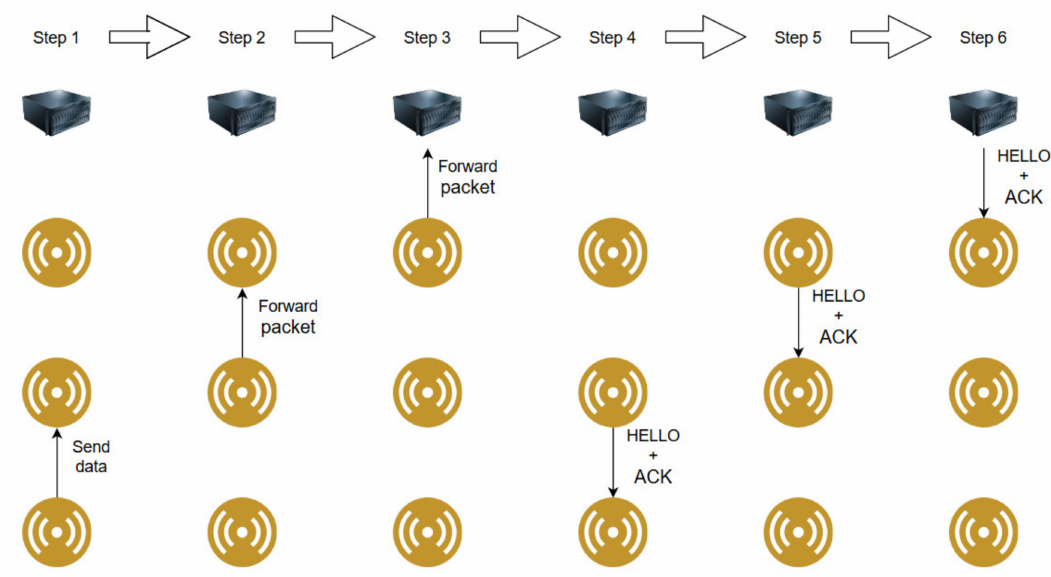
Figure 5. Flow of operations when no packet loss occurs.